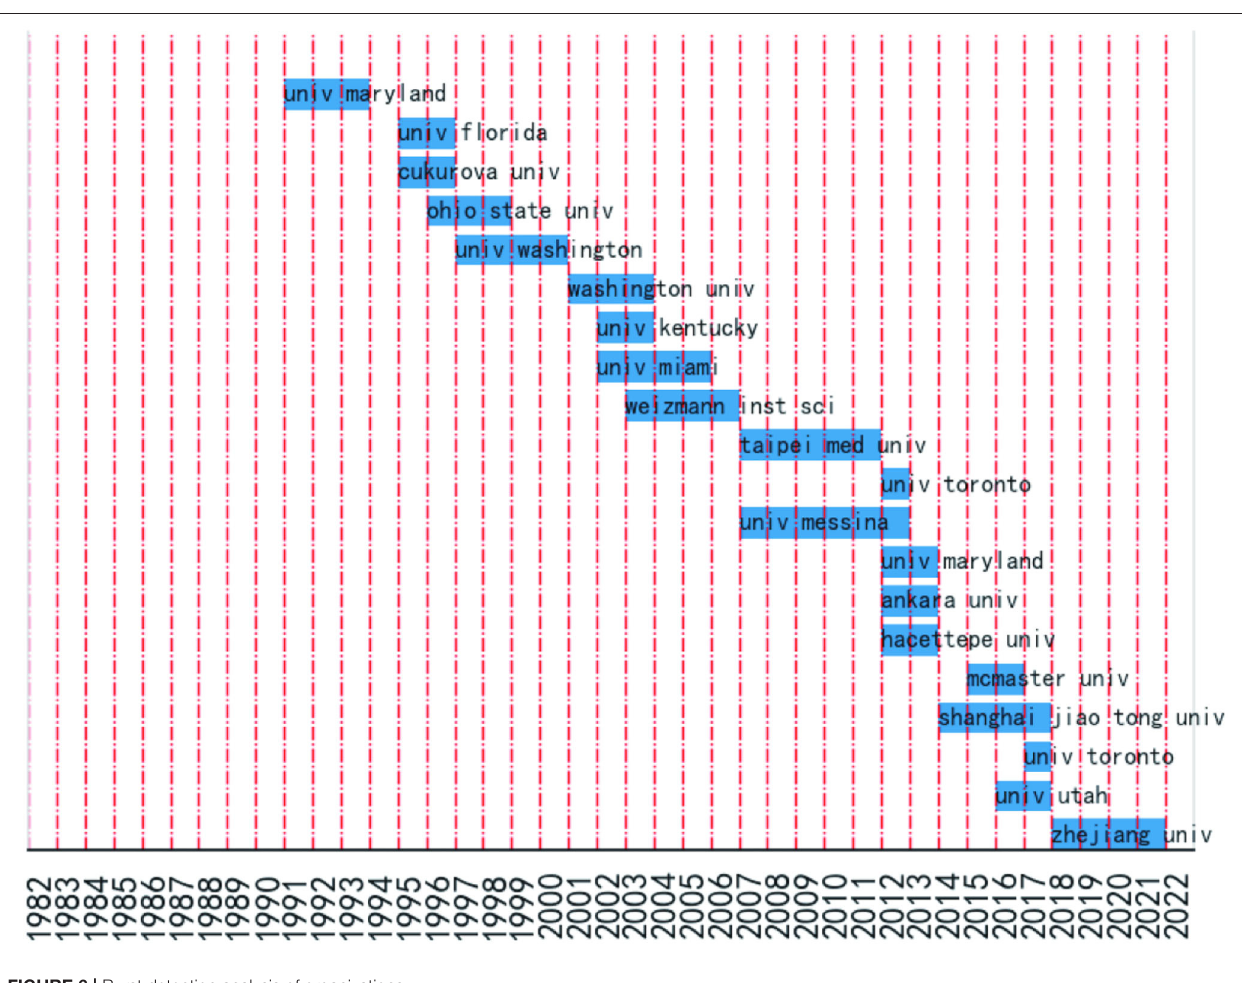
FIGURE 6 | Burst detection analysis of organizations.